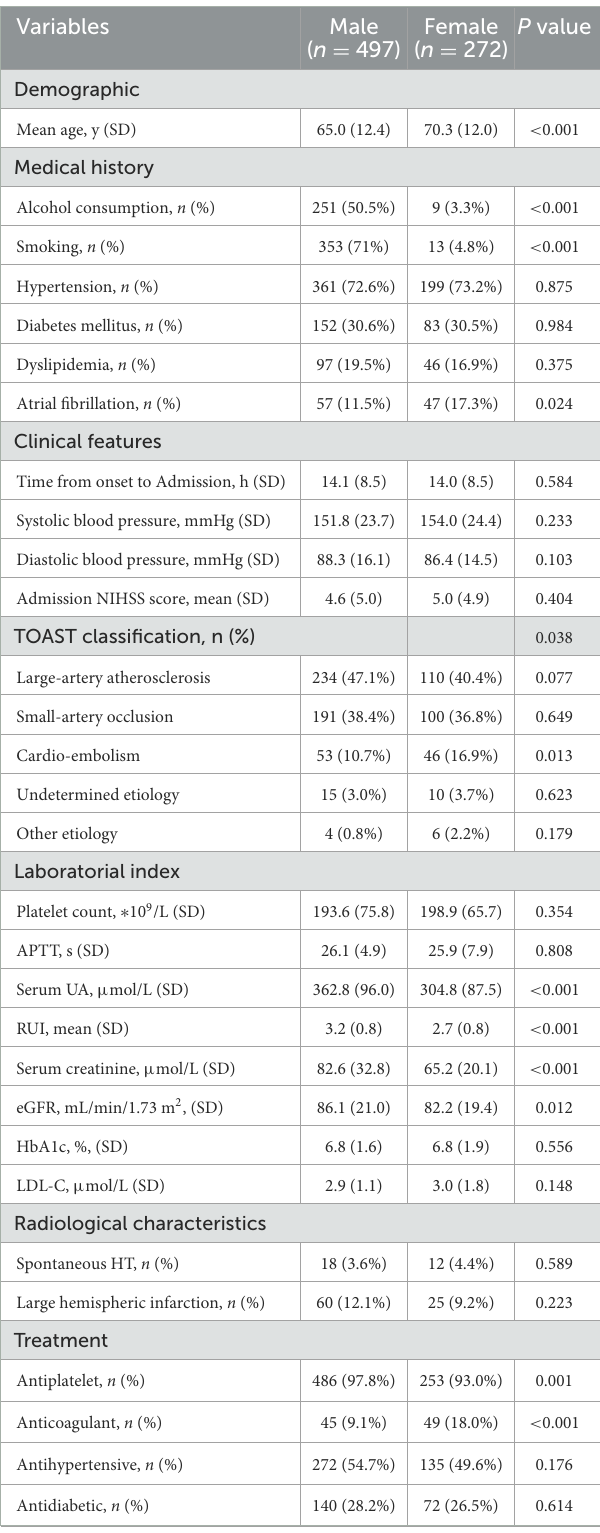
TABLE 1 Baseline characteristics of